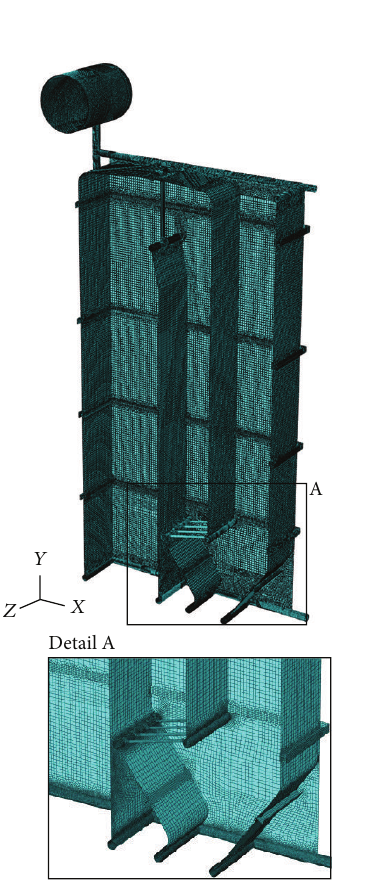
Figure 8: Finite element mesh-calculation model APPROX.